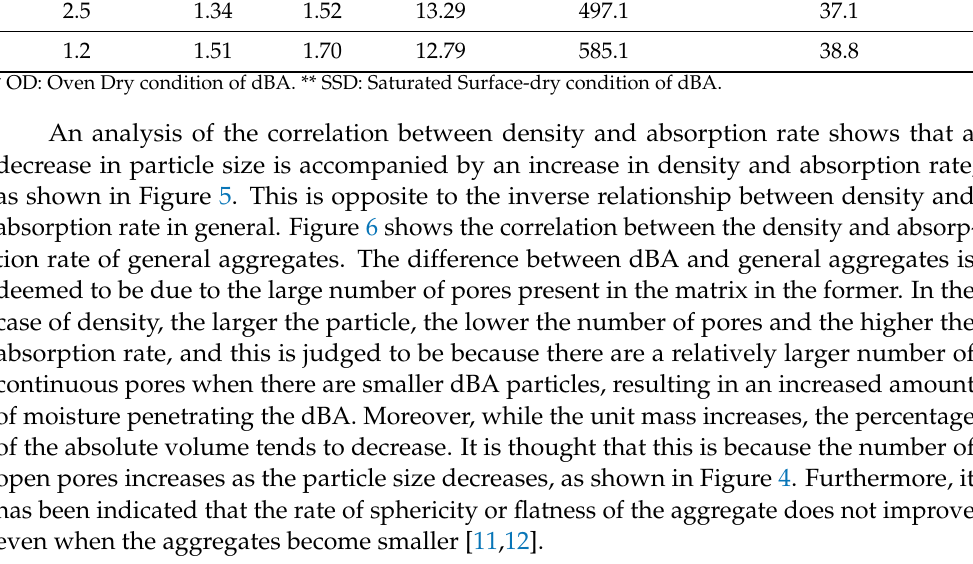
Table 1. Physical properties of dBA according to size.